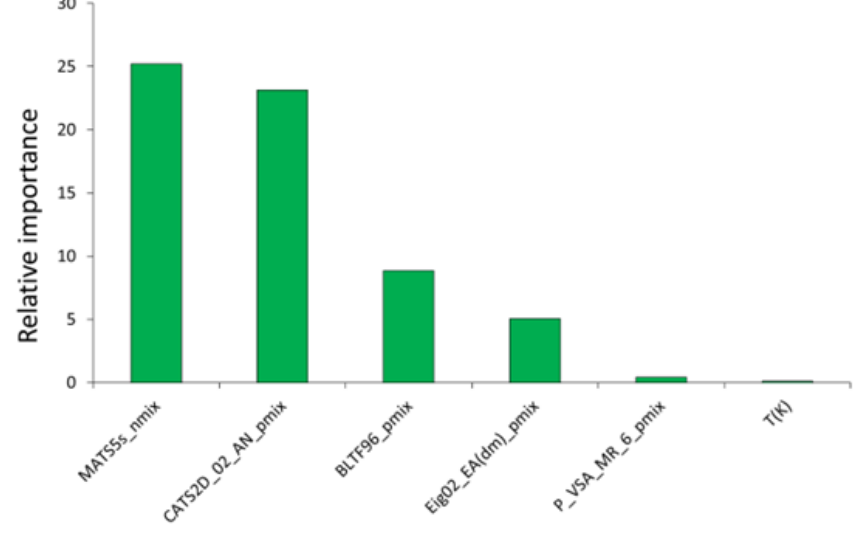
Figure 4. Relative importance of the descriptors found in the best individual model M12.